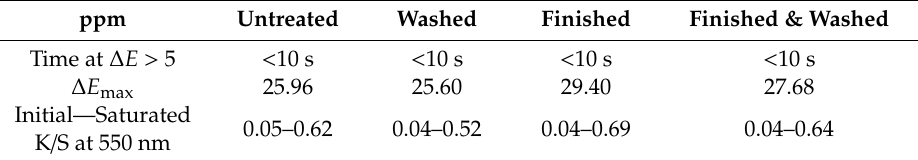
Table 4. Color change data according to washing and finishing of the dyed sensor.